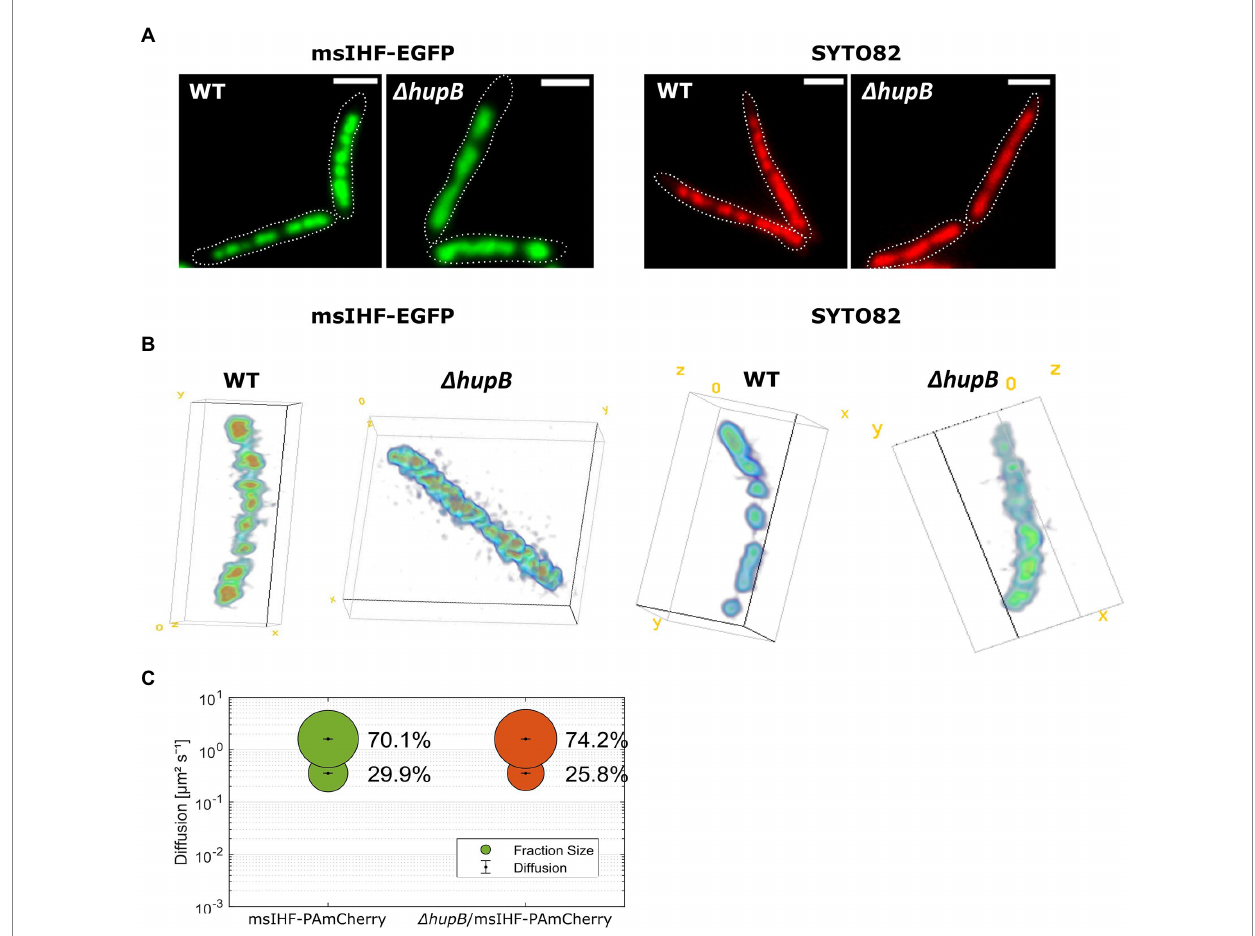
FIGURE 4 Analysis of changes in nucleoid morphology in msIHF-EGFP and Δ hupB /msIHF-EGFP strains in comparison to Δ hupB and wild-type M. smegmatis cells stained with SYTO82 chromosomal dye. (A) Wide-field epifluorescence microscopy-derived micrographs of representative cells from the analyzed strains. Cell outlines are indicated with dotted white lines. Scale bar, 2 μ m. (B) Lattice SIM combined with Z-stacks of the analyzed strains. 3D models of the nucleoids were generated in Fiji using the Volume Viewer plugin. (C) Results of single-particle tracking experiments. Bubble plot presenting obtained diffusion coefficients and the subpopulations sizes for msIHF-PAmCherry and Δ hupB /msIHF-EGFP